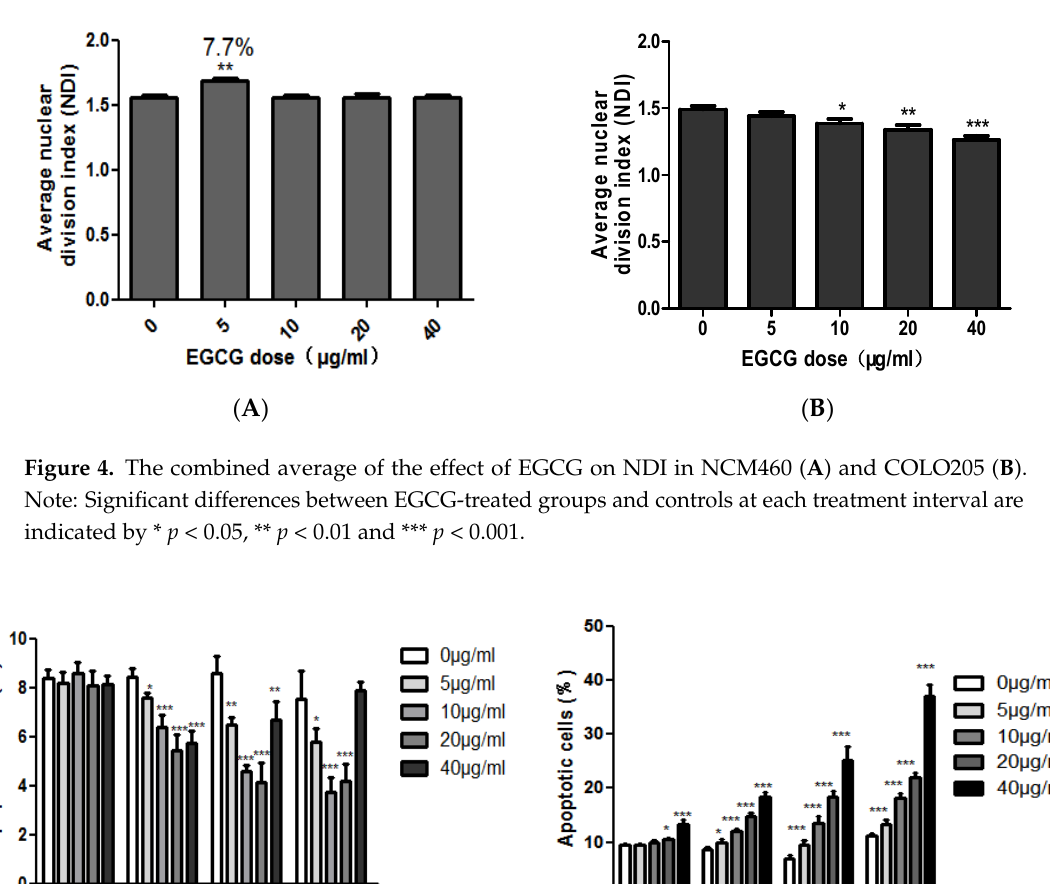
Figure 4. The combined average of the effect of EGCG on NDI in NCM460 ( A ) and COLO205 ( B ). Note: Significant differences between EGCG-treated groups and controls at each treatment interval are indicated by * p < 0.05, ** p < 0.01 and *** p < 0.001.